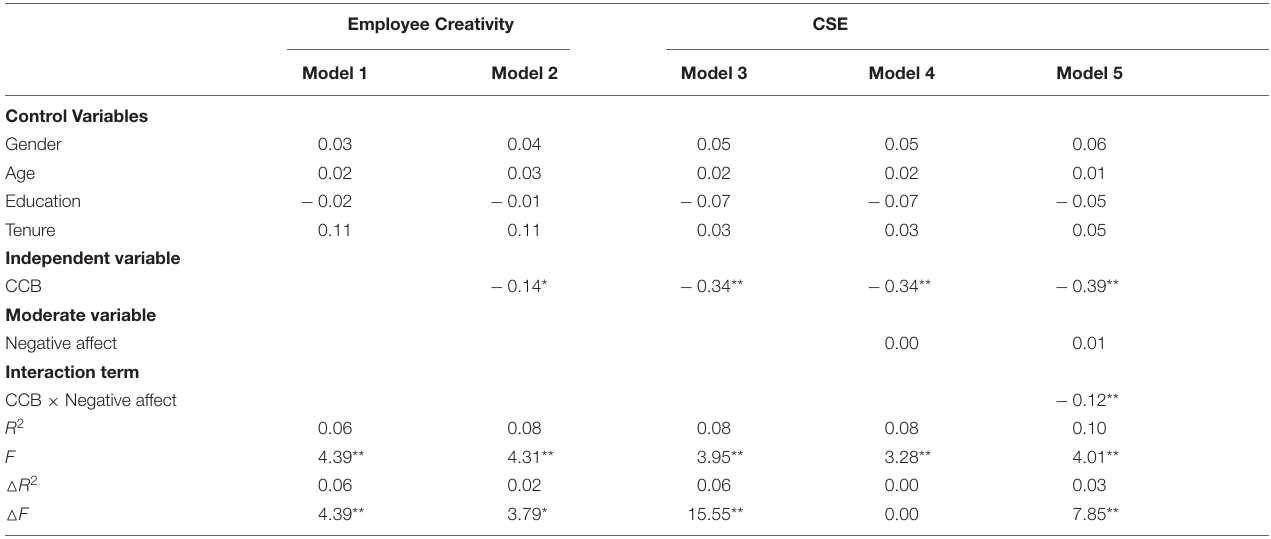
TABLE 3 | Regression summary for the mediating role of CSE and the moderating role of negative affect ( N = 251).